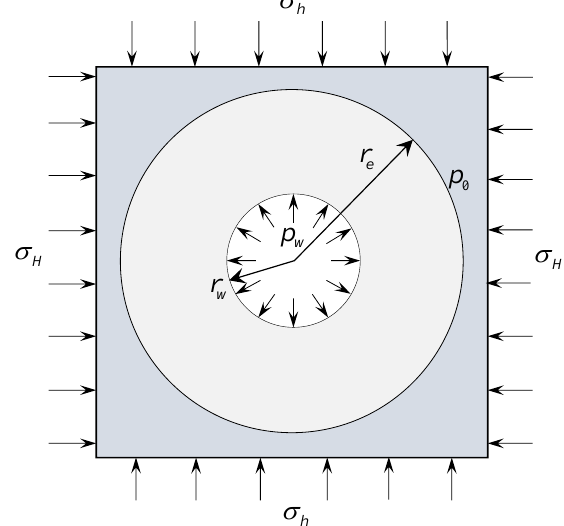
Figure 2. Mechanical model of the vertical wellbore.